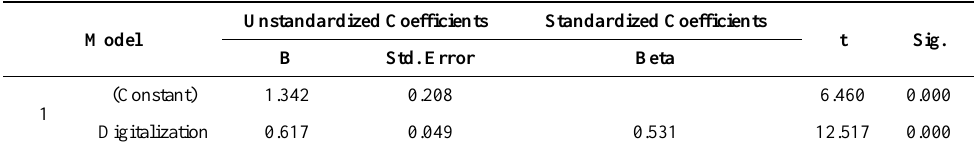
Table 6. OLS model for digitalization and quality of